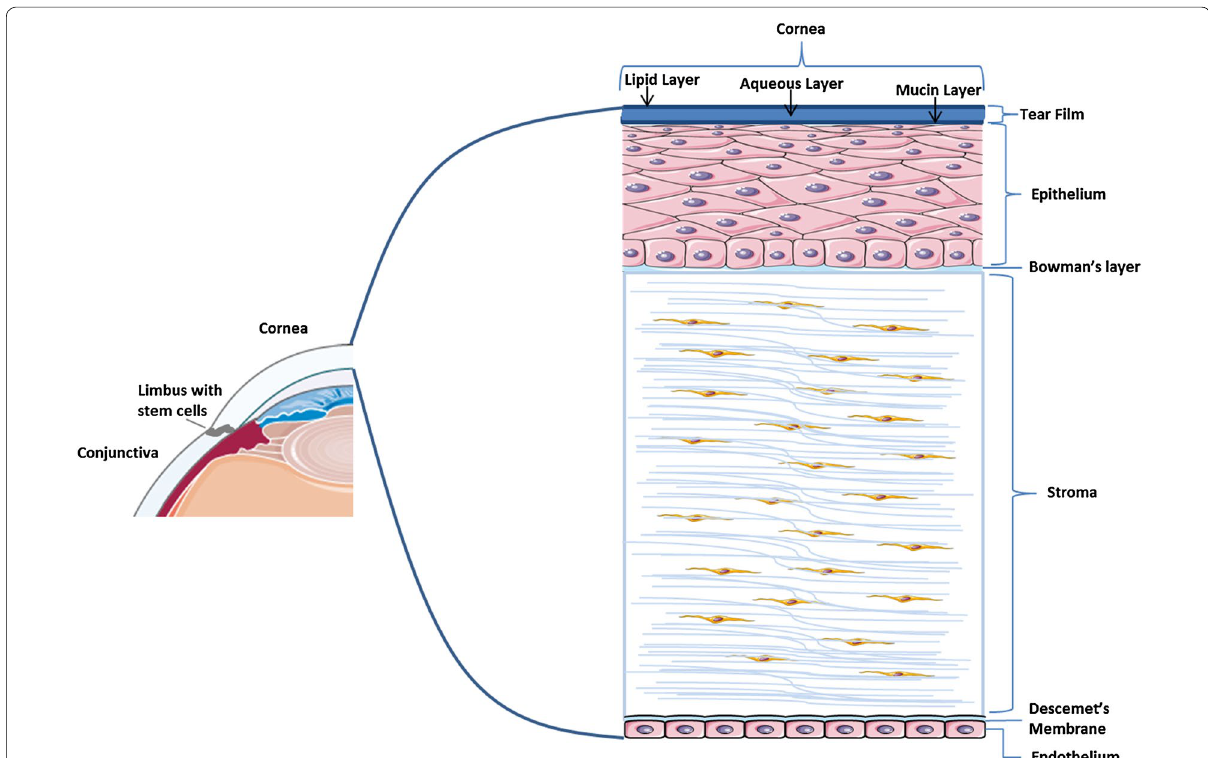
Fig. 1 Structure of the cornea. Some images were provided by servier medical